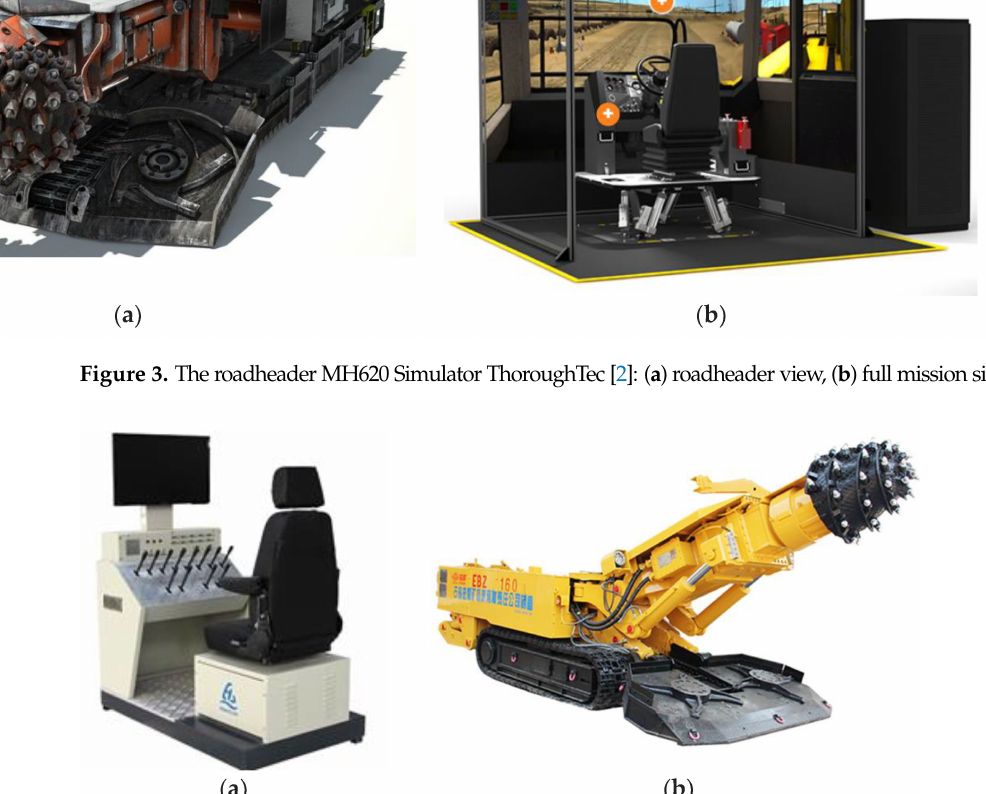
Figure 4. The roadheader EBZ Simulator by Xuzhou Hanlin Technology Co., Ltd. [3]: ( a ) simulator station, ( b )